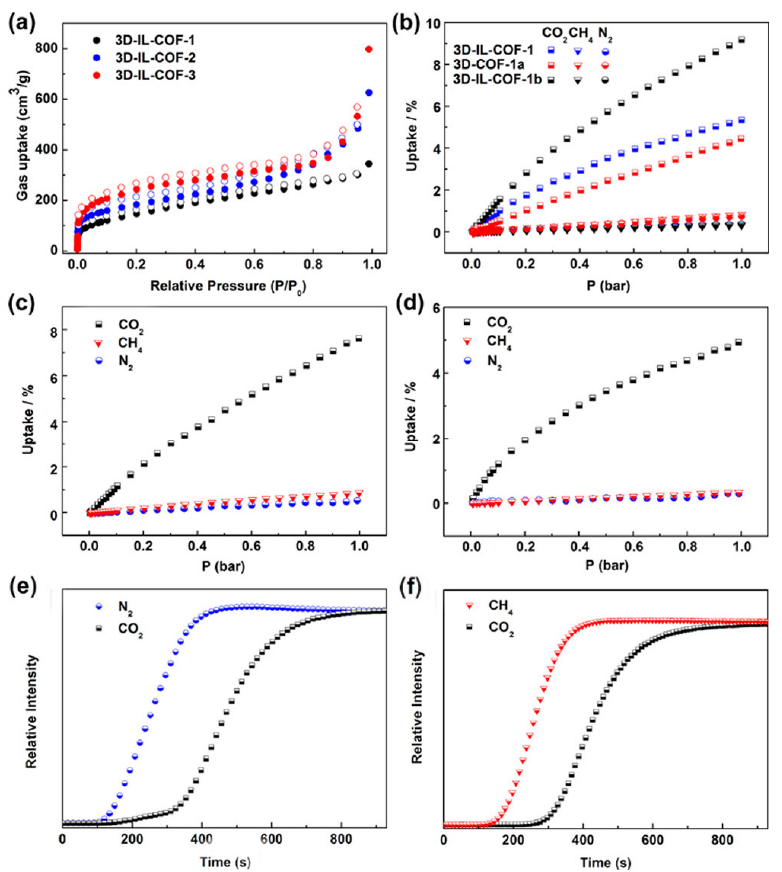
Figure 24. ( a – f ) The impressive presentation in the separation of CH 4 /CO 2 /N 2 using 3D-IL-COFs. Reprinted (adapted) with permission from [55]. Copyright {2018} American Chemical Society.